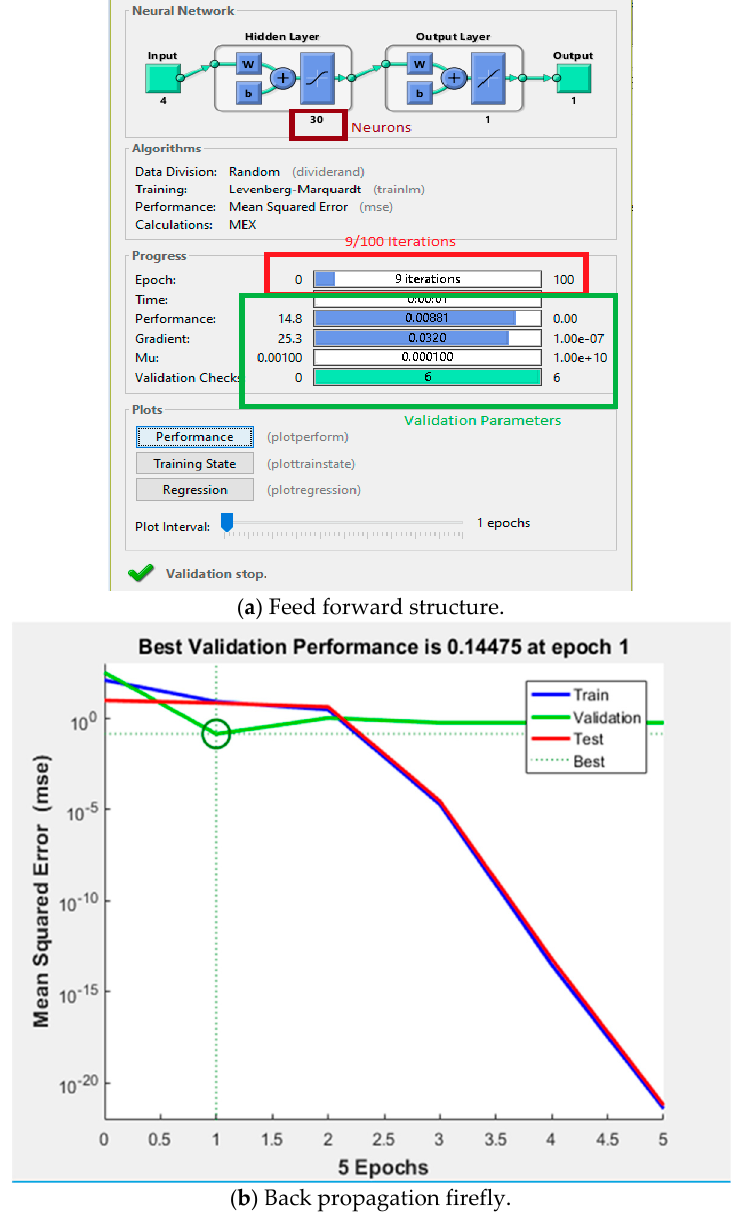
Figure 8. ( a ) Feed Forward Structure; ( b ) Back Propagation Firefly.